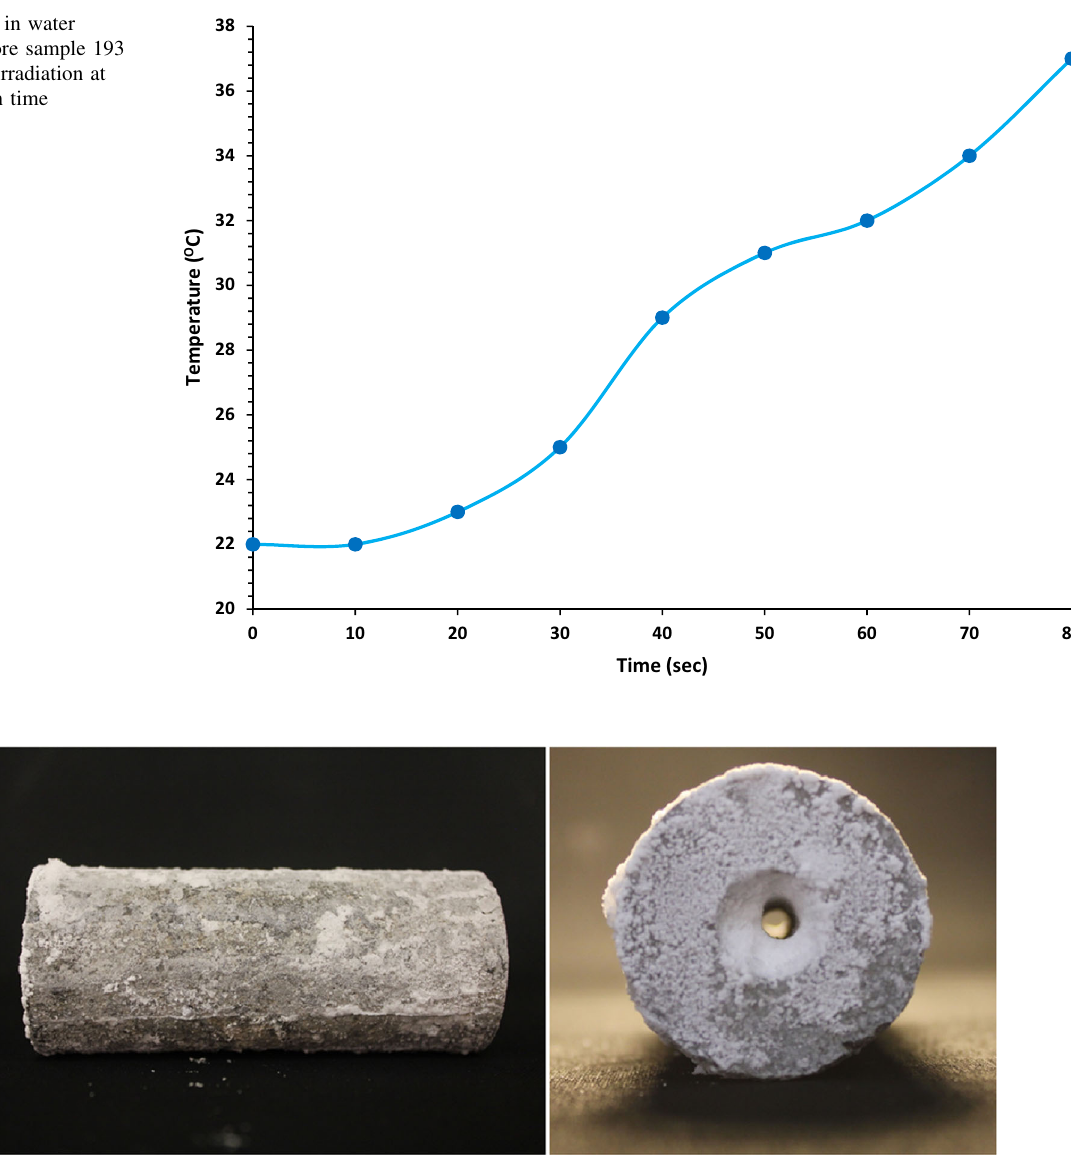
Fig. 11 Induced hole in cemented core with NaCl